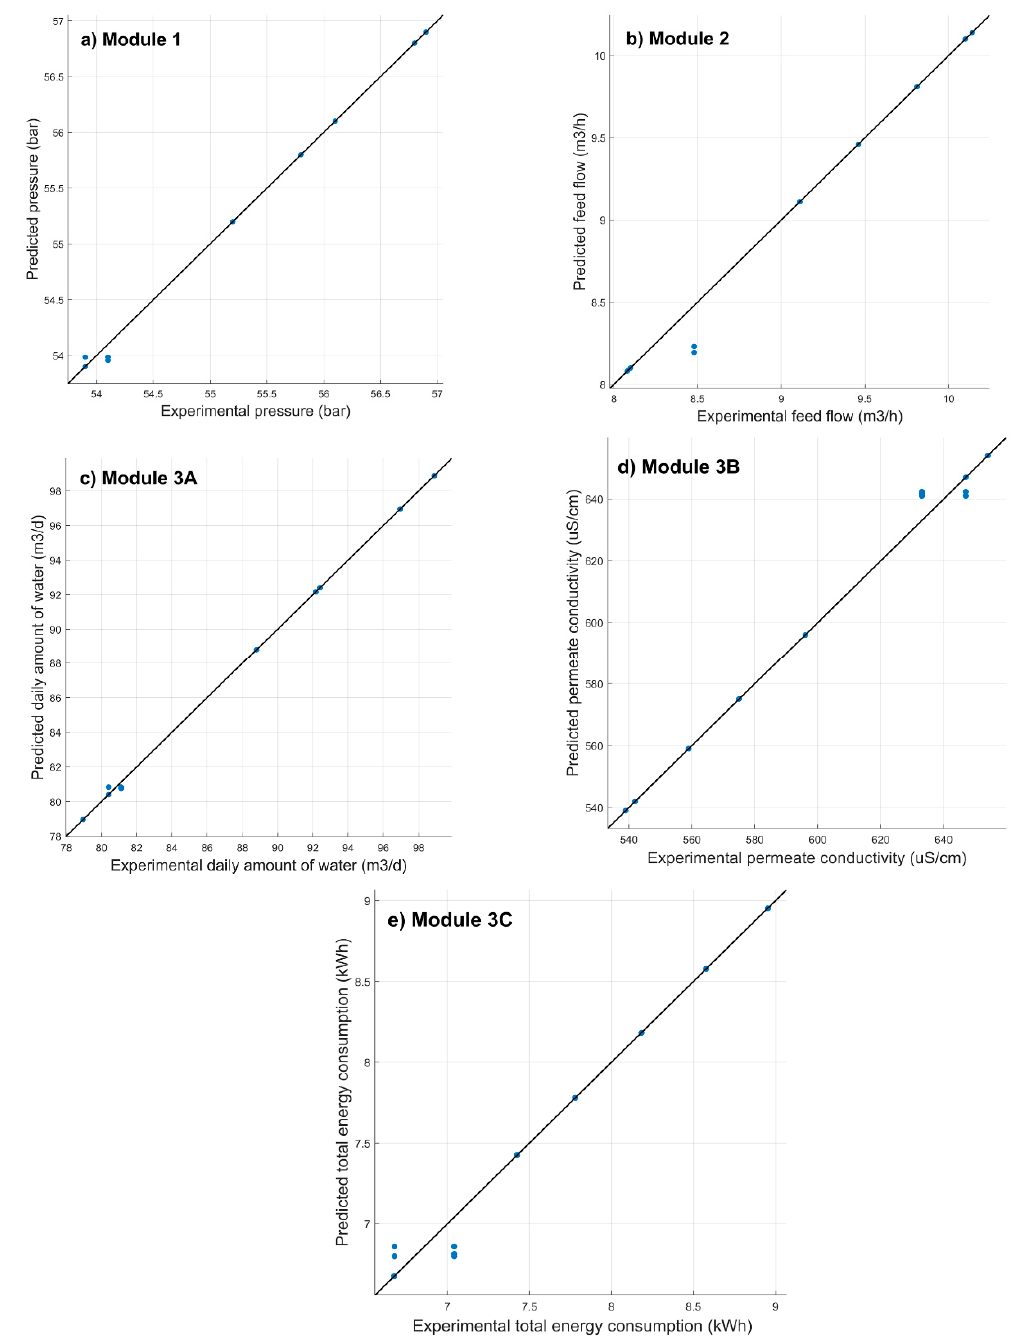
Figure 6. Coefficients of determination of the modules. Note, as was identified in Table 5, that the correlation coefficients of the system modules had very satisfactory results.